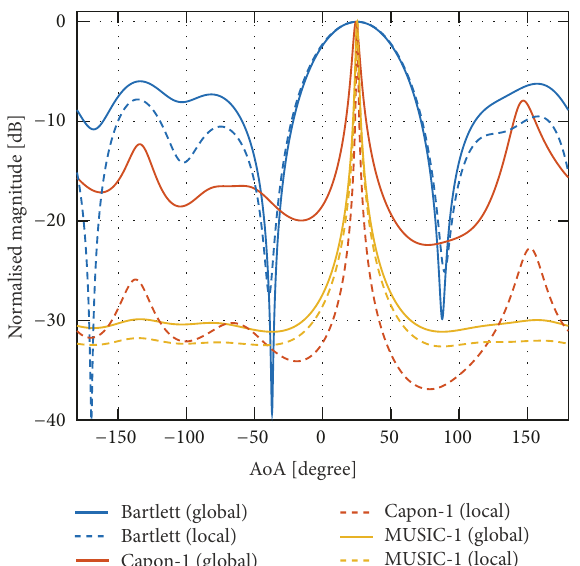
Figure 8: Spectra of Bartlett beamformer, Capon-1 beamformer, and MUSIC-1 for global and local calibration. The global calibration matrix has been calculated by the method of Sommerkorn. Mea- surement data with a single source at 25 ∘ are used to calculate the